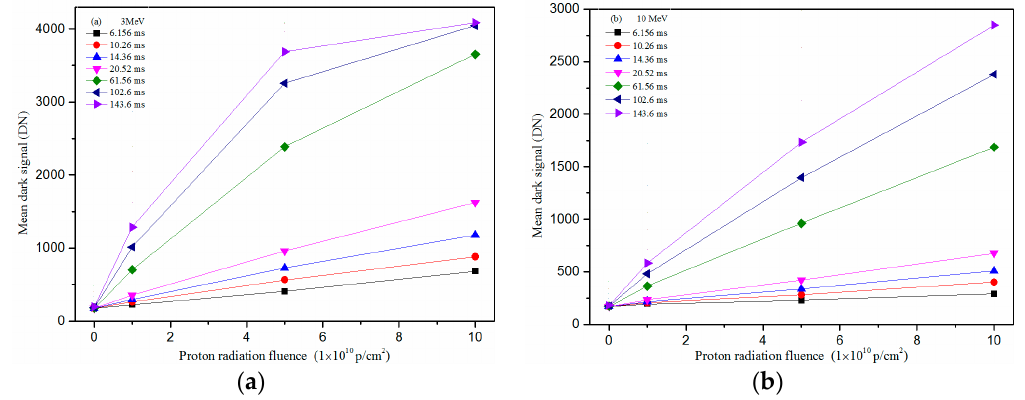
Figure 4. Mean dark signal versus proton fluence at different integration time: ( a ) proton energy: 3 MeV; and ( b ) proton energy: 10 MeV.